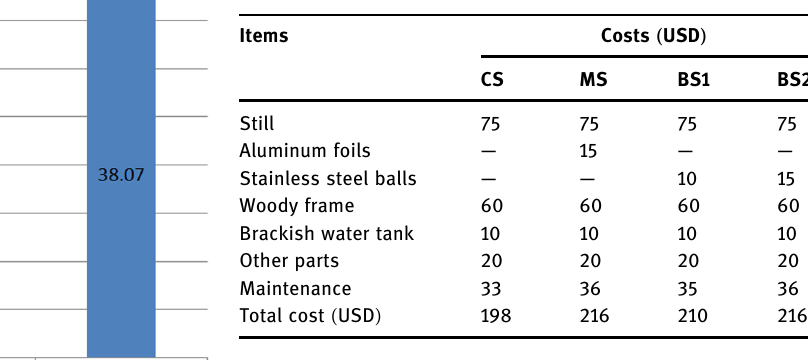
Figure 15: Productivity enhancement of fresh water.